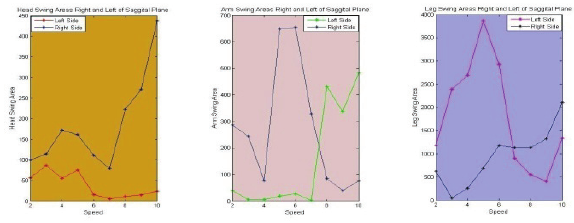
Fig . 8. Variation of features with speed for a single person using polygon area.